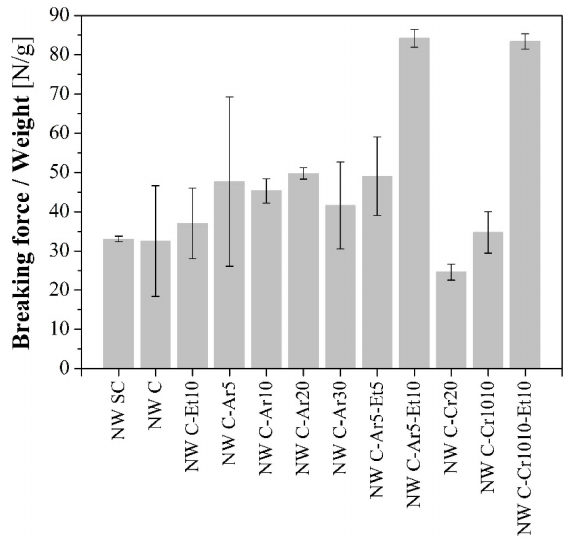
Figure 12. Breaking force of the NW normalized by the sample weight for comparative purposes